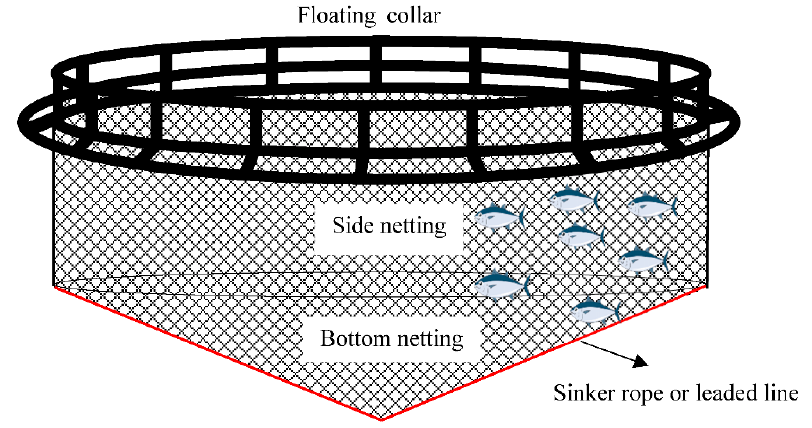
Figure 1. Schematic diagram of prototype net cage used for farming pacific bluefin tuna.